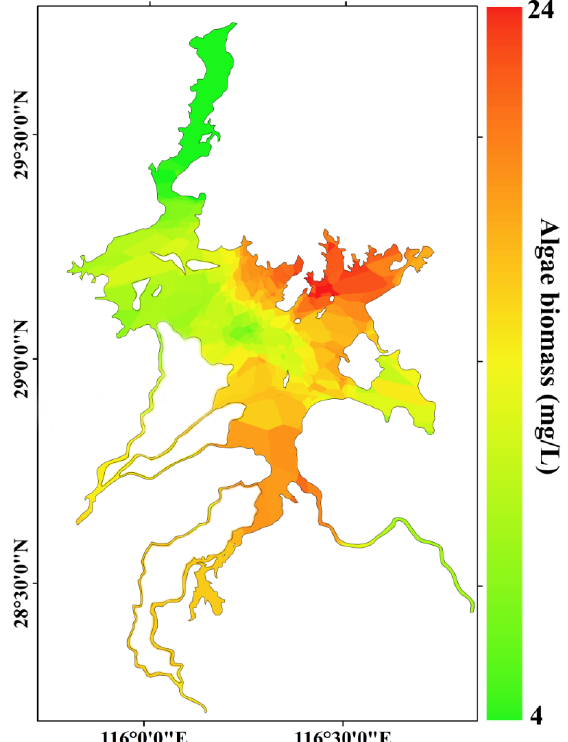
Figure 8. Map of the depth-averaged velocity (m/s) averaged over the high water level period of MIKE 21 runs and a close-up of the velocity field for the region of interest. Red arrows represent the streamlines and associated flow directions. Note that the “Undefined Value” represents dry land.